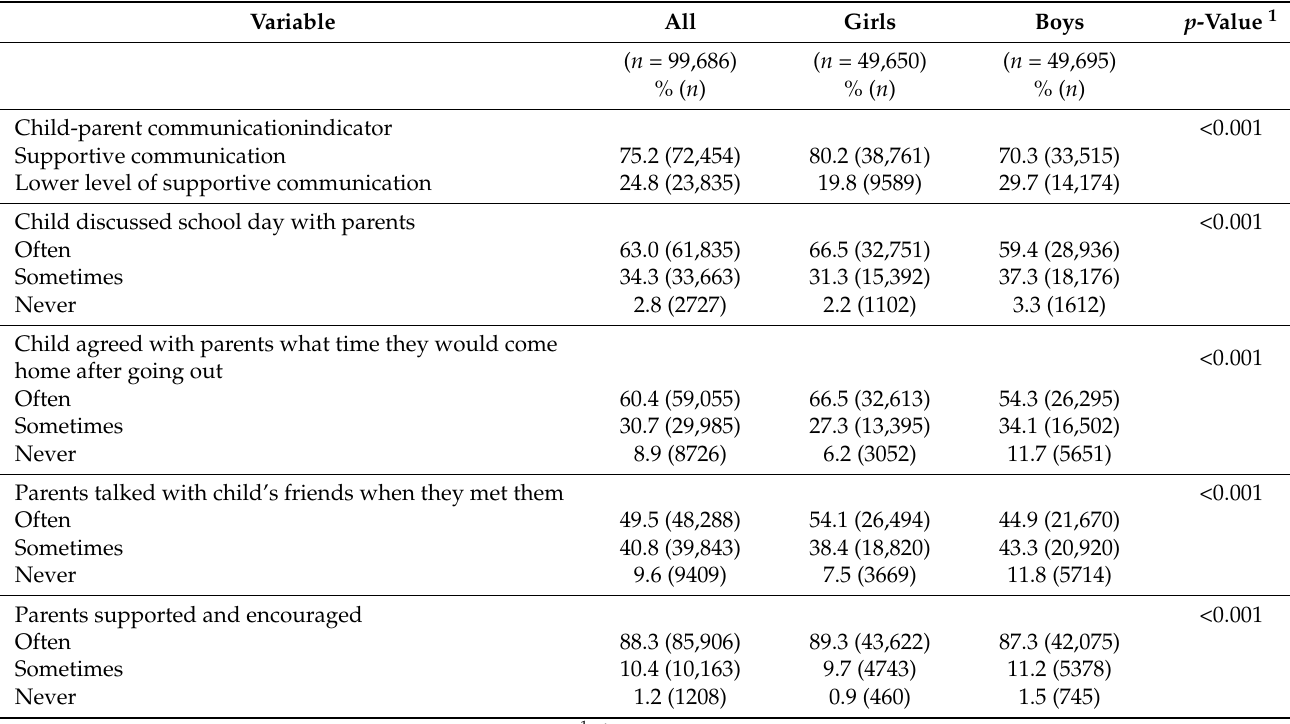
Table 4. Child-parent relationships of girls and boys aged 9–11 years [49].